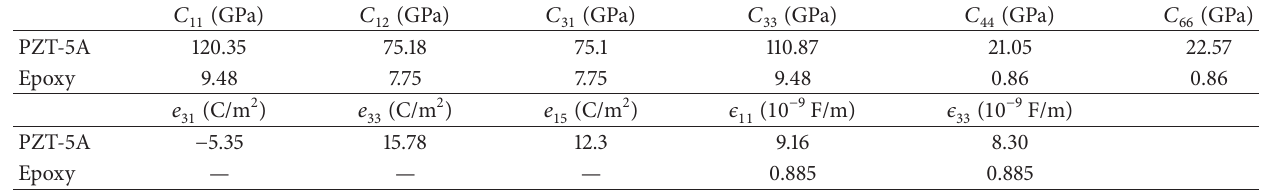
Table 1: Material properties of the piezocomposite constituents: Fiber (PZT-5A) and Matrix (Epoxy)